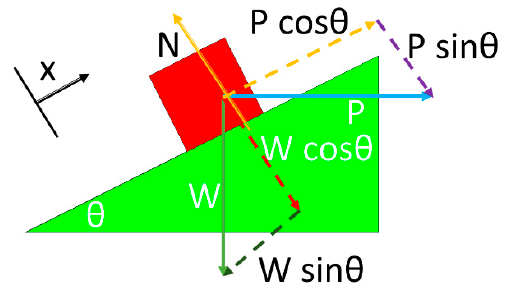
Figure 2. Free body diagram of a screw pump.